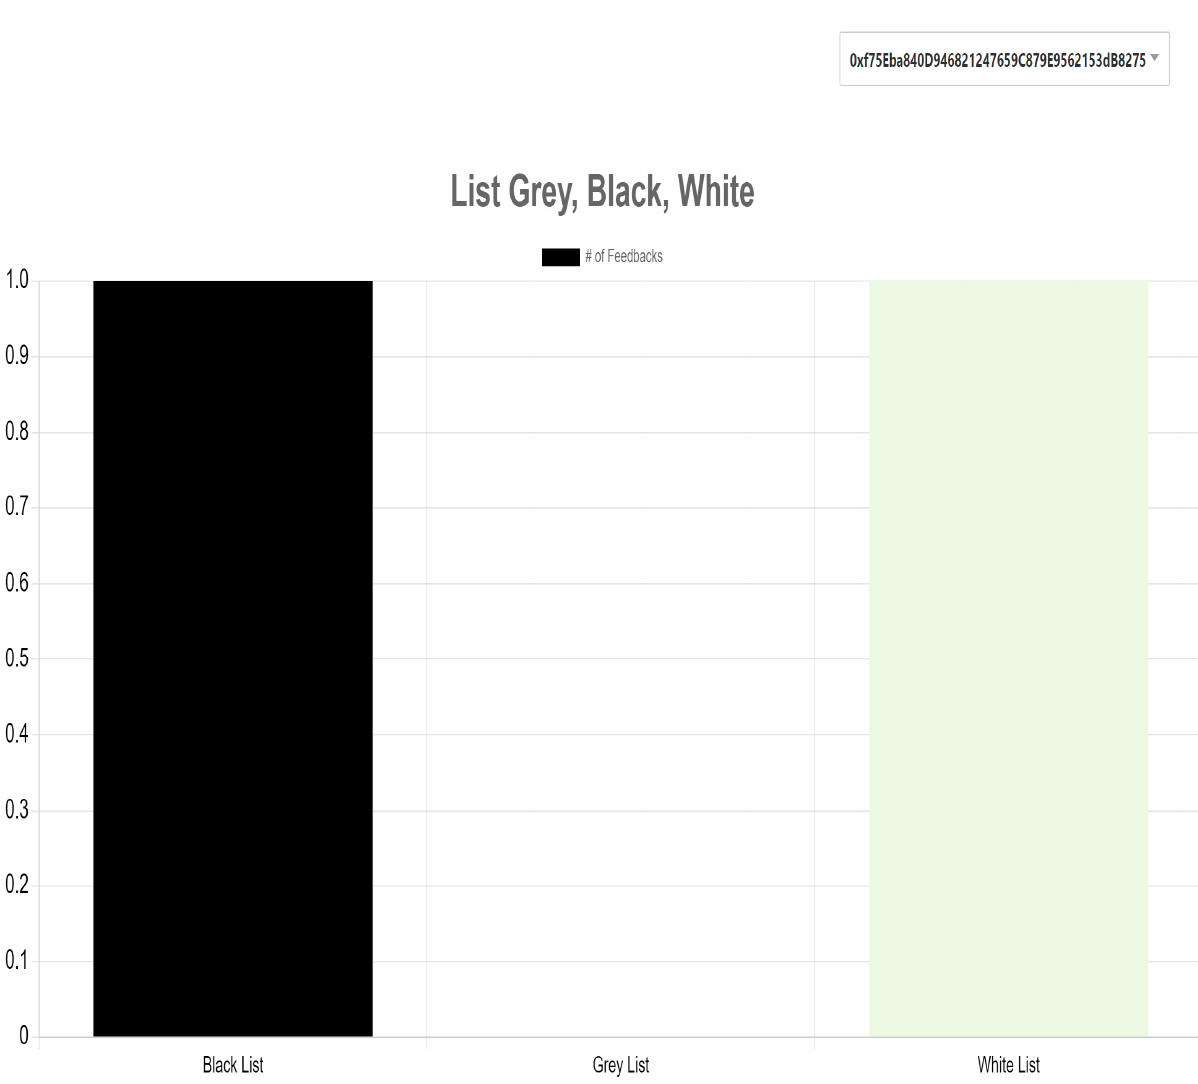
Figure 10. Variation in SP status based on the Reputation Values for SP3.